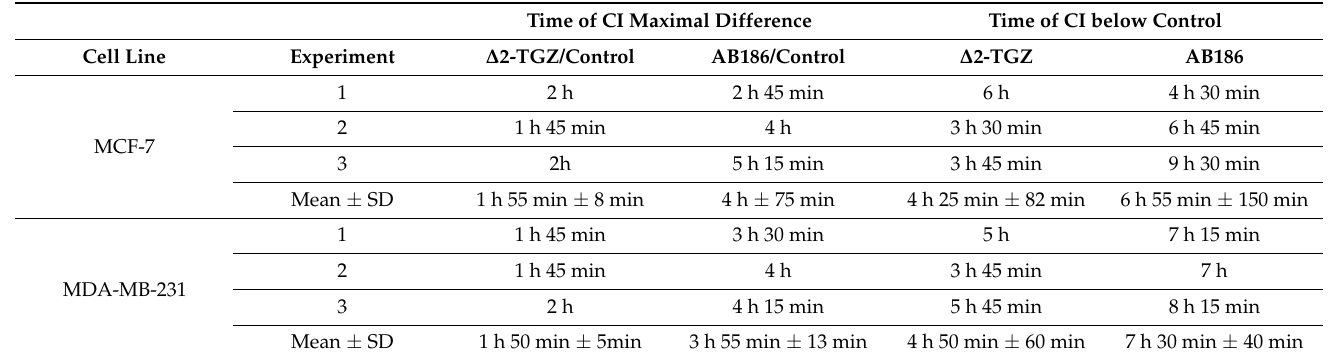
Table 1. Maximal difference of cell index between control condition and treated condition, Δ 2- TGZ/Control and AB186/Control, was determined for three independent experiments. The mean of maximal difference of CI for each treatment was determined in MCF-7 and MDA-MB-231 cells.